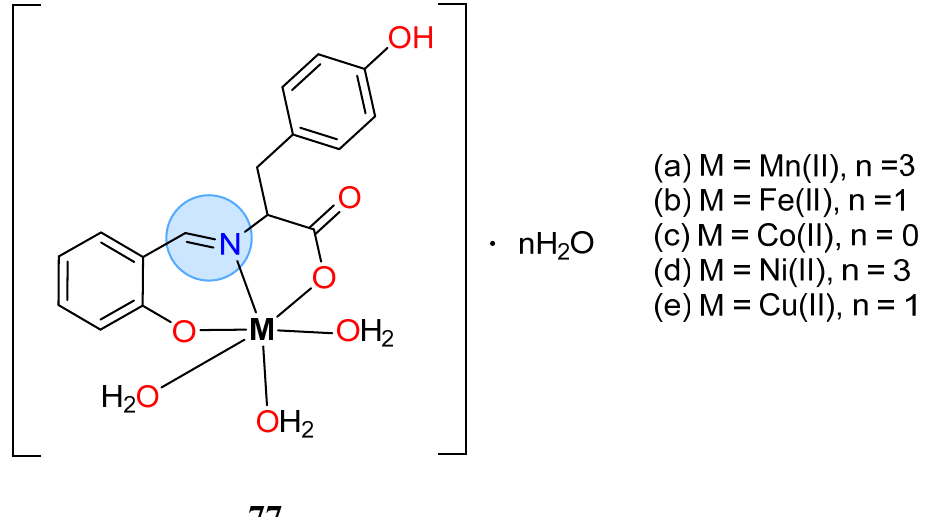
Figure 37. Transition metal complexes with a Schiff base derived from salicylaldehyde and L-tyrosine amino acid, evaluated for their antimicrobial activity.